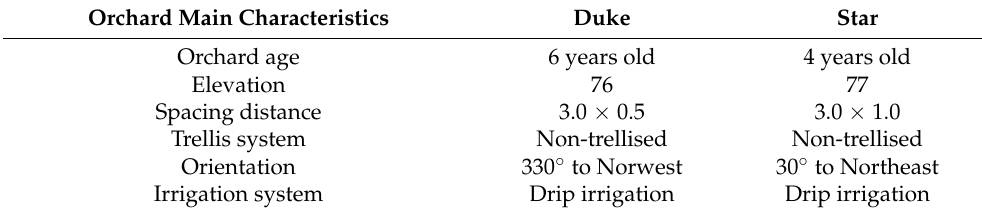
Table 1. Main characteristic of ‘Duke’ and ‘Star’ orchards under study.